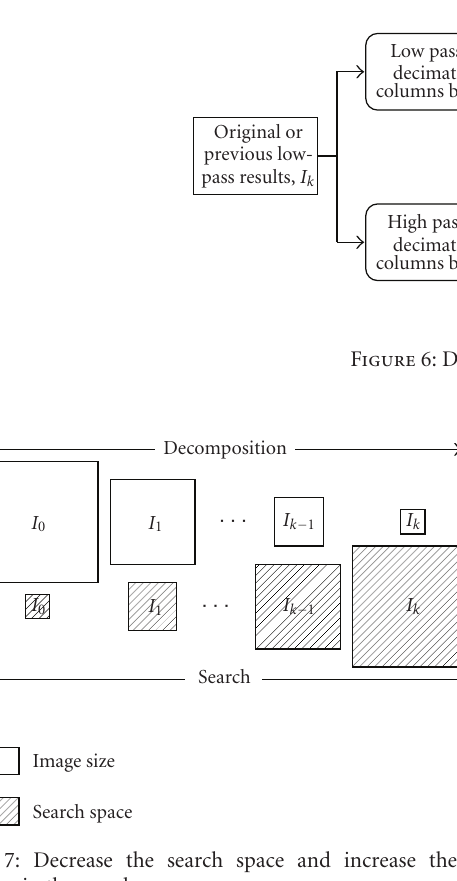
Figure 5: Artifacts due to discretization in rigid-body transformation ((a) the original image; (b) the transformed image). Rows